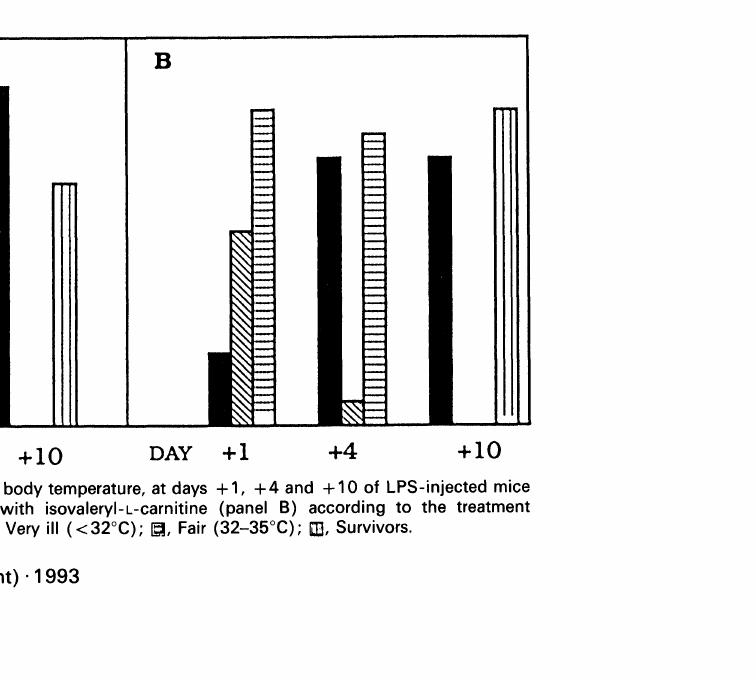
FIG. 3. Health conditions, as evaluated by body temperature, at days +1, +4 and +10 of LPS-injected mice treated either with saline (panel A) or with isovaleryl-L-carnitine (panel B) according to the treatment protocol reported in Table 2. i, Dead; l, Very ill (<32C) I, Fair (32-35C) El,